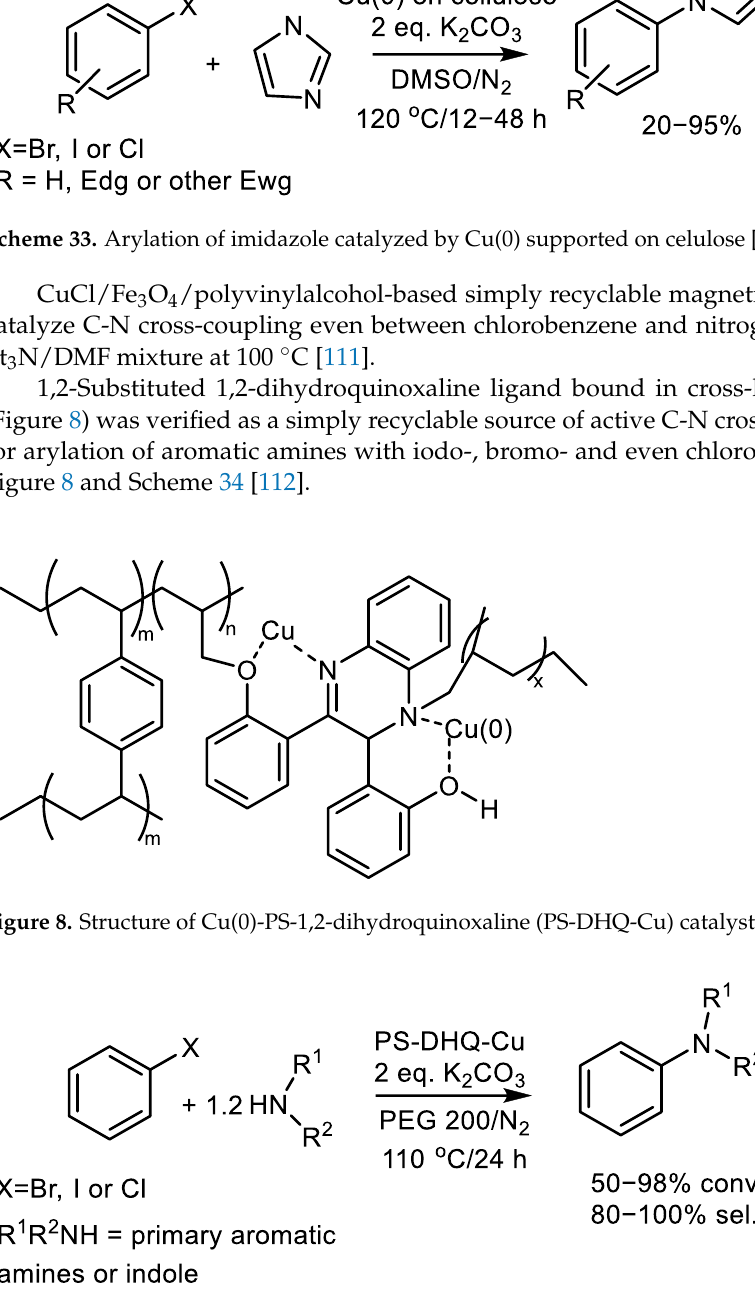
Scheme 34. Arylation of anilines or indole by Ar-X [112].